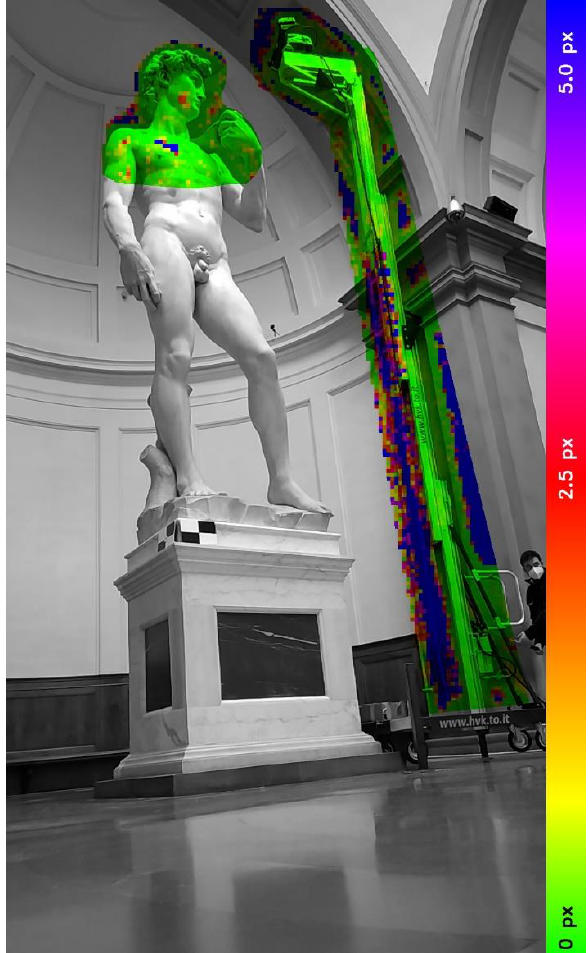
Figure 4: Superimposition of DIC analysis’s results on 2D picture of David statue.